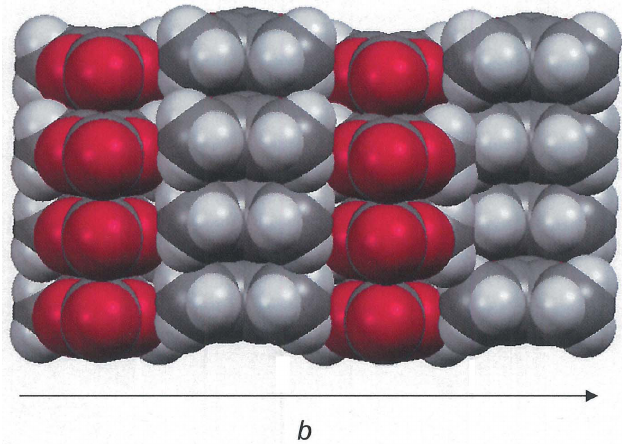
Figure 5 Space-filling plot of the unit-cell packing in 1 as viewed along the length of the linear strands, which are orthogonal to the paper plane.